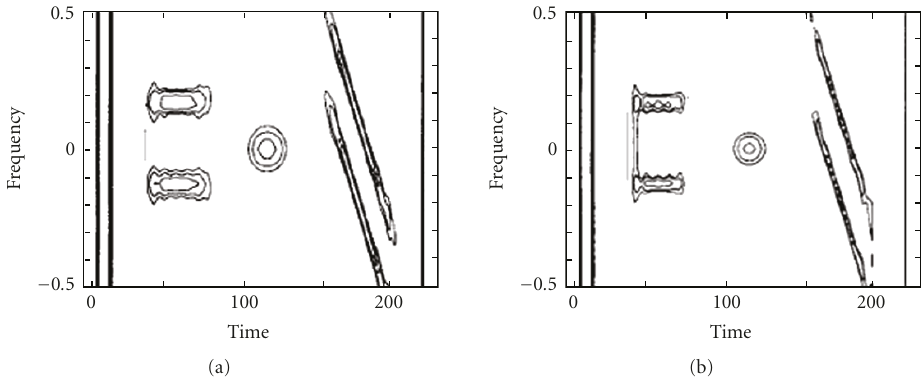
Figure 17: New adaptive TFDs of the synthetic test signal of three impulses, two simultaneous sinusoidal pulses, a Gaussian pulse, and two parallel linear chirps: (a) adaptive optimal-kernel (AOK) TFD computed using volume α = 1 . 4, window width 2 T = 32, and one kernel optimization iteration per input time sample, (the AOK TFD is quite insensitive to these values); (b) AOK TFD with additional time-support (cone) constraint [146] (adopted from Jones and Baraniuk